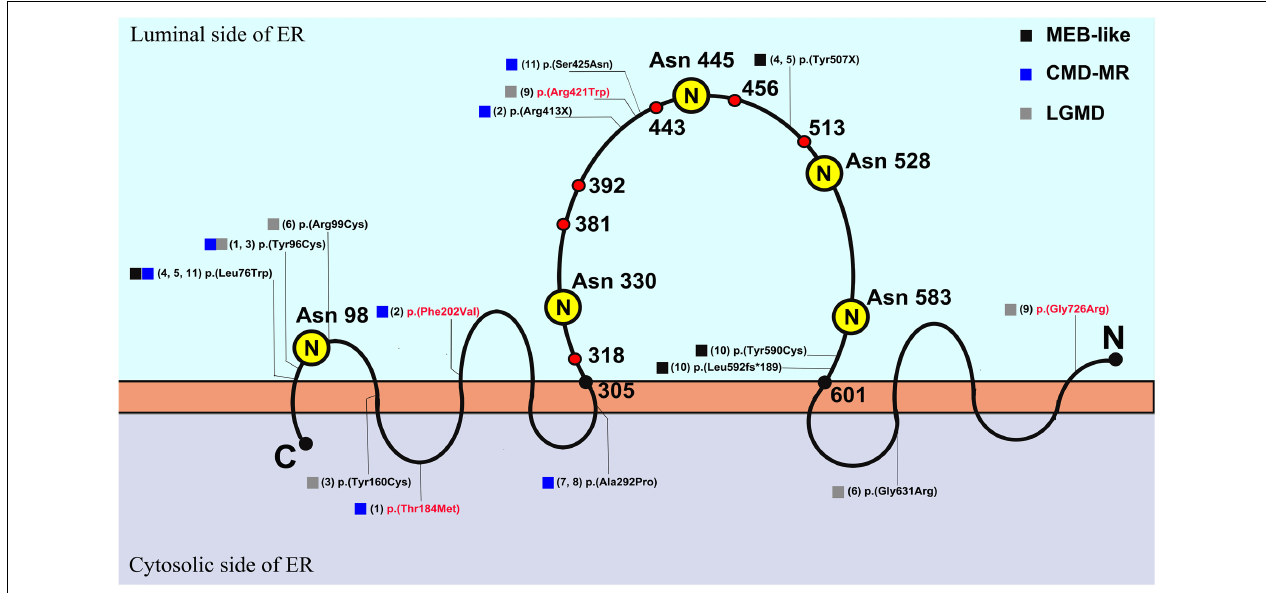
FIGURE 4 | The schematic diagram of POMT2 (Manya et al., 2010) and the distribution of variants in this cohort. The capital letter N in yellow circle represented N-glycosylation sites, which are located on the amino acids of Asn 98, Asn 330, Asn 445, Asn 528, and Asn 583. The amino acids 305–601 represented the large hydrophilic loop, and it contains three presumed MIR domains, amino acid 318–381, 392–443, and 456–513, which are the important areas that affect enzymatic activity. The number in brackets represented the serial number of patients, and the variants in red font had been clinically reported; ER, endoplasmic reticulum; C, C terminal; N, N